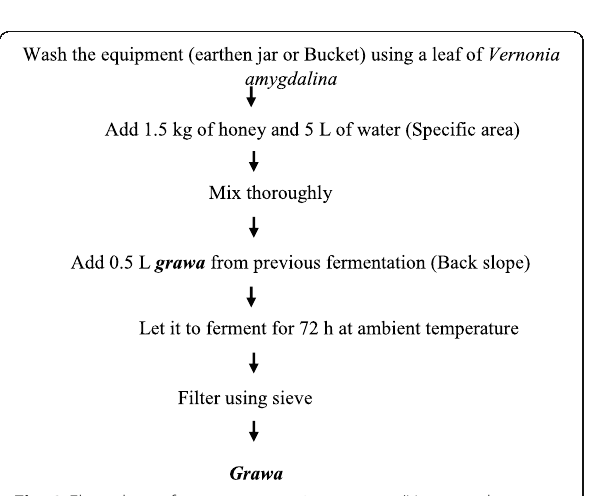
Fig. 3 Flow chart of grawa preparation process (Nemo